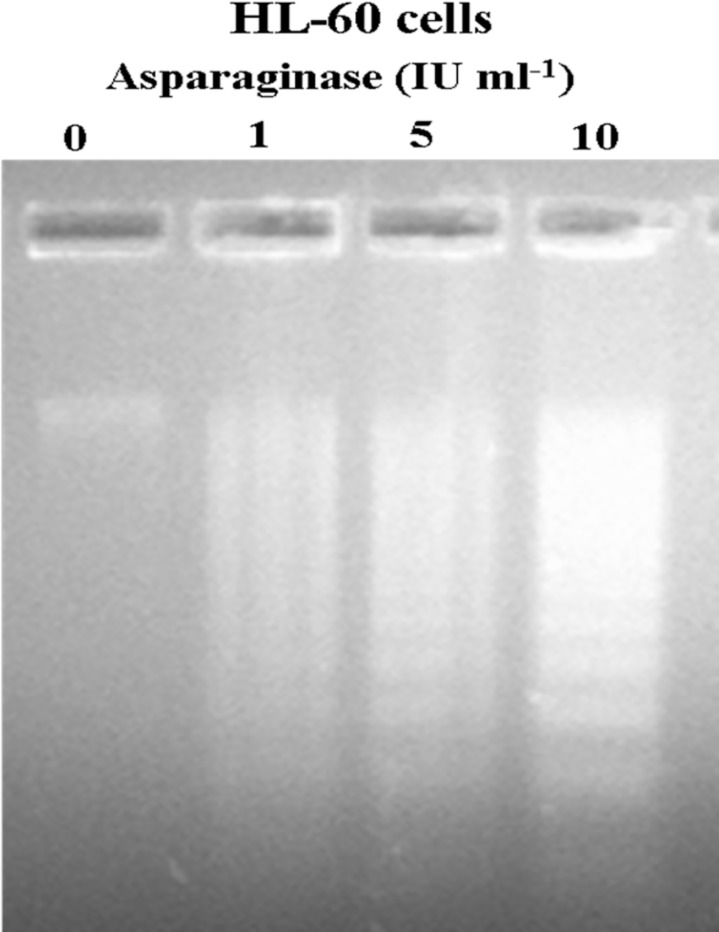
Agarose gel electrophoresis of genomic DNA extracted from HL-60 cells following the treatment of asparaginase.HL-60 cells treated with different concentrations of E. cloacae asparaginase for 24 h. Genomic DNA was isolated and electrophoresed on 1.8% agarose gel as described in Material and Method.